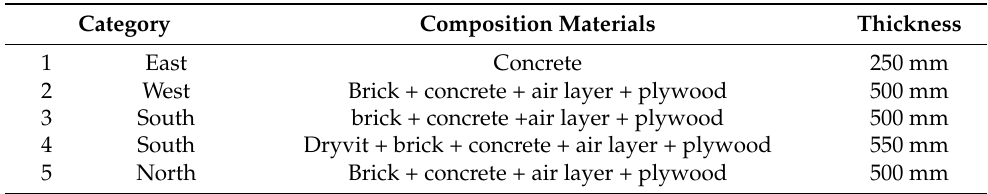
Table 1. Wall material composition and thickness, according to the orientation of the experimen- tal building.